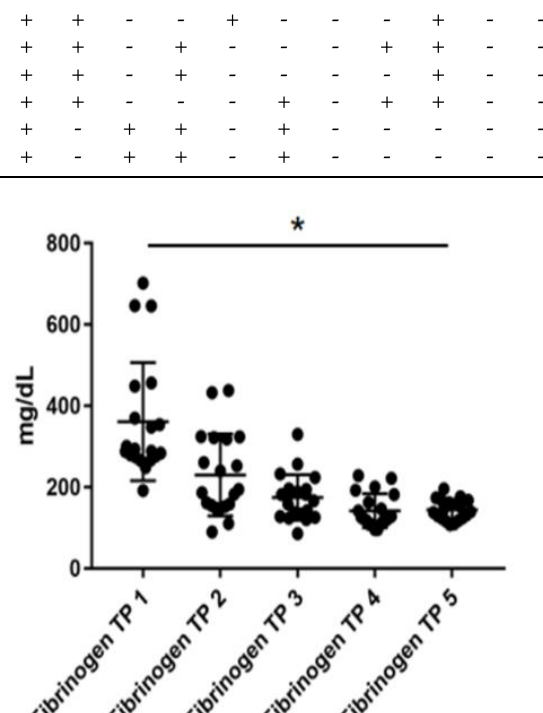
procedure. The fibrinogen levels decreased during the five TPE treatments, from 361.8 ± 32.5 to 145.3 ± 5.5 mg/dL ( p < 0.0001, Figure 2). There was no significant reduction in white blood cell (WBC) count and platelets (9.38 ± 1.03 vs. 9.26 ± 0.70/nL, p = 0.8791; 241.2 ± 14.0